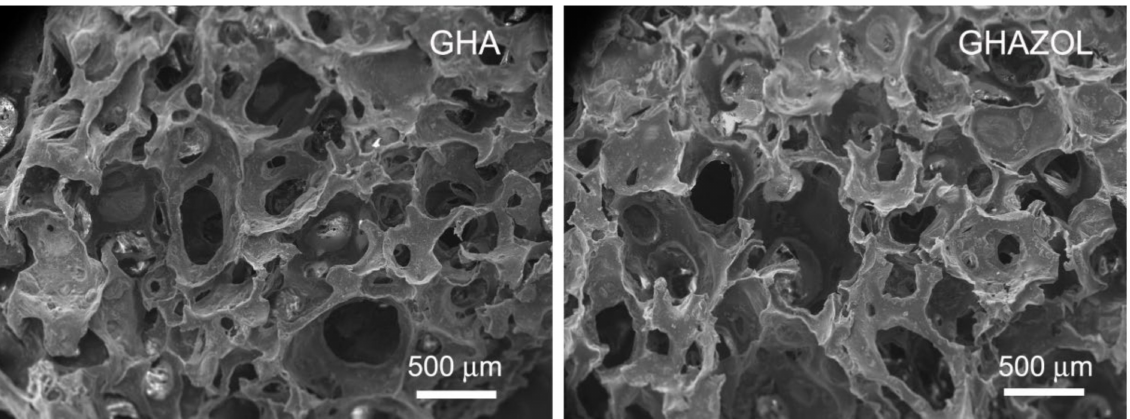
Figure 3. SEM micrographs of the cross-sections of the composite scaffolds: GHA and GHAZOL show porous structures, with no significant difference. Scale bar (500 nm) is common for the two images, for direct comparison. Magnifications = 30 ×